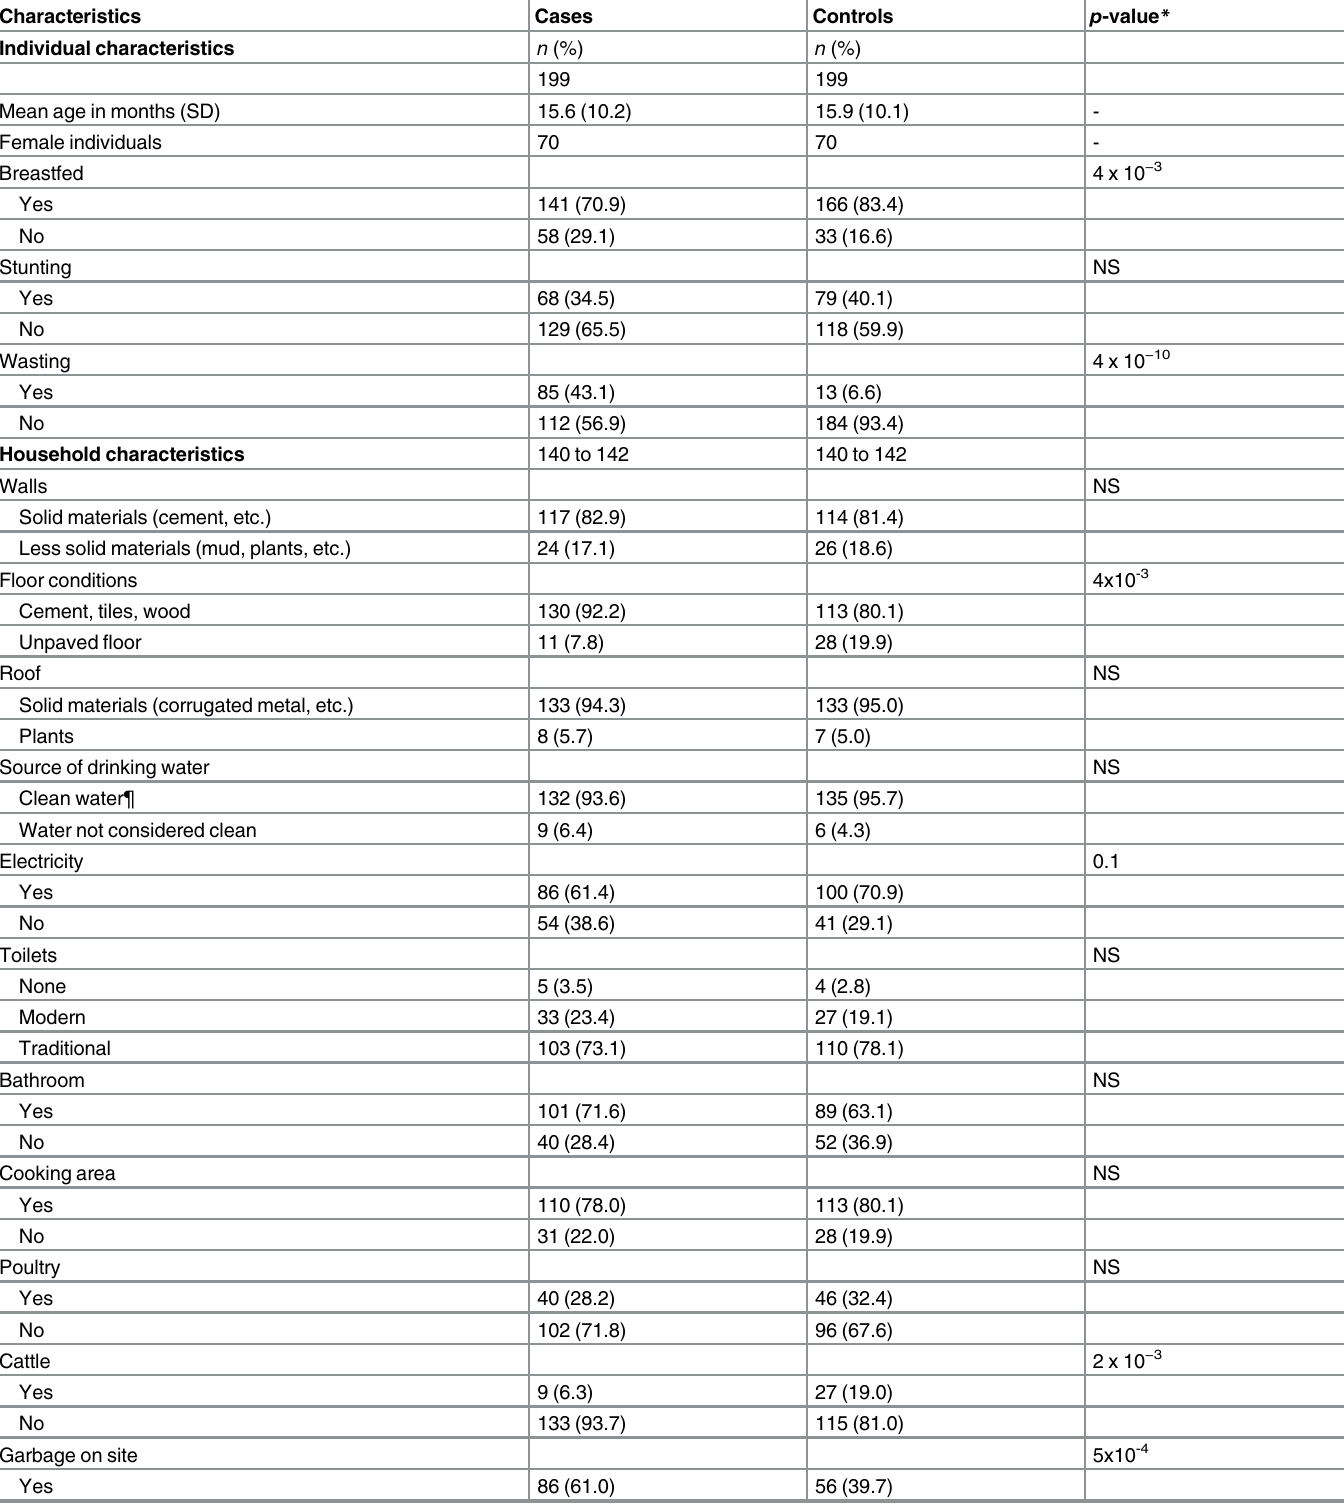
Table 1. Individual and household characteristics of the cases and controls from Antananarivo and Moramanga, 2011 – 2014.